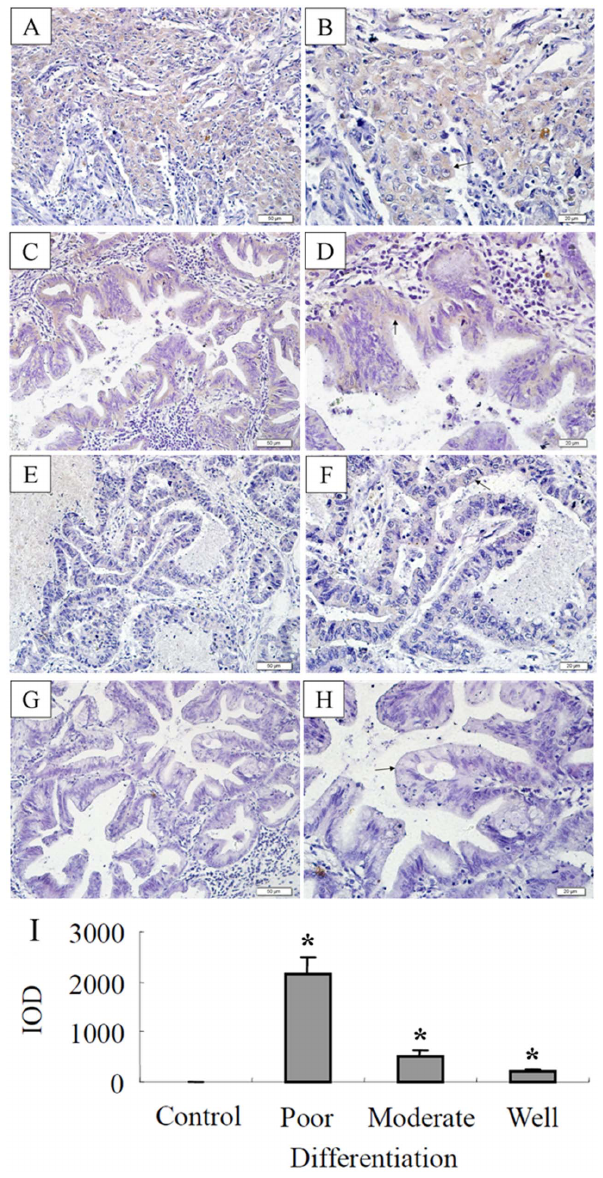
Figure 2. FST expression in lung adenocarcinoma tissues. (A, B) The poorly differentiated, (C, D) moderately differentiated and (E, F) well differentiated lung adenocarcinoma were stained by anti-FST mono- clonal antibody, respectively. The arrows in A–F represented the positive staining area for FST. (G, H) No positive staining area was found with normal mouse IgG instead of anti-FST monoclonal antibody as a procedural background control. The graph represents the integrated optical density (IOD) value obtained using IMAGEJ (http://rsbweb.nih. gov/ij/).